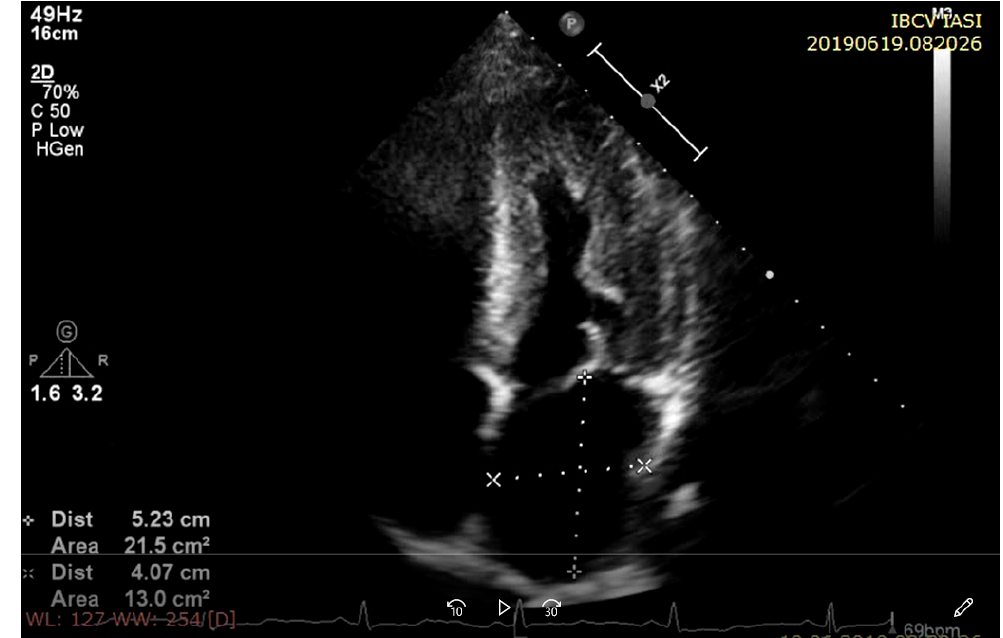
Figure 3. Transthoracic echocardiogram, apical four-chamber view in a patient with cardiac amyloidosis showing: increased thickness of left ventricle wall with “granular sparkling” appearance, increased biatrial dimensions in contrast with a small left ventricle cavity, and pericardial effusion.